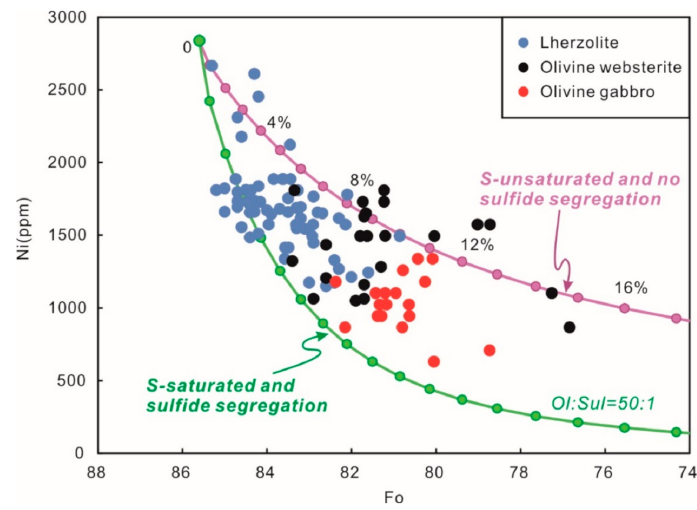
Figure 11. Model of olivine crystallization showing the variations of Ni content and Fo value in the Baixintan deposit: the detailed modelling principle and process can be seen in Table